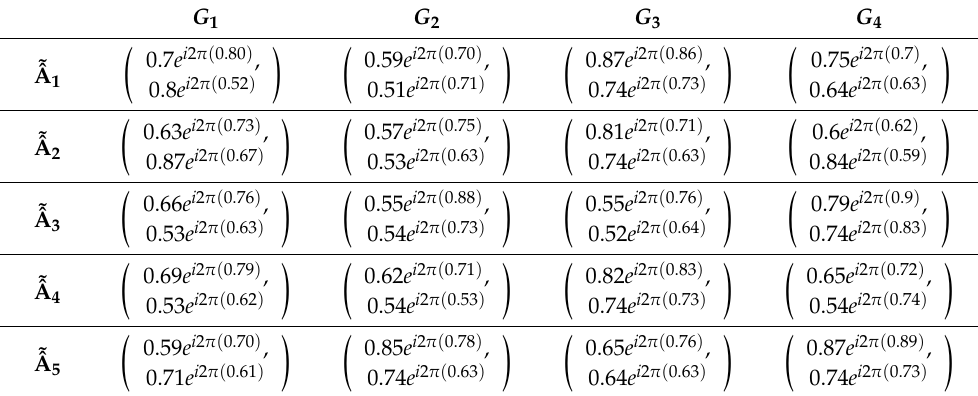
Table 11. Decision matrix for Example